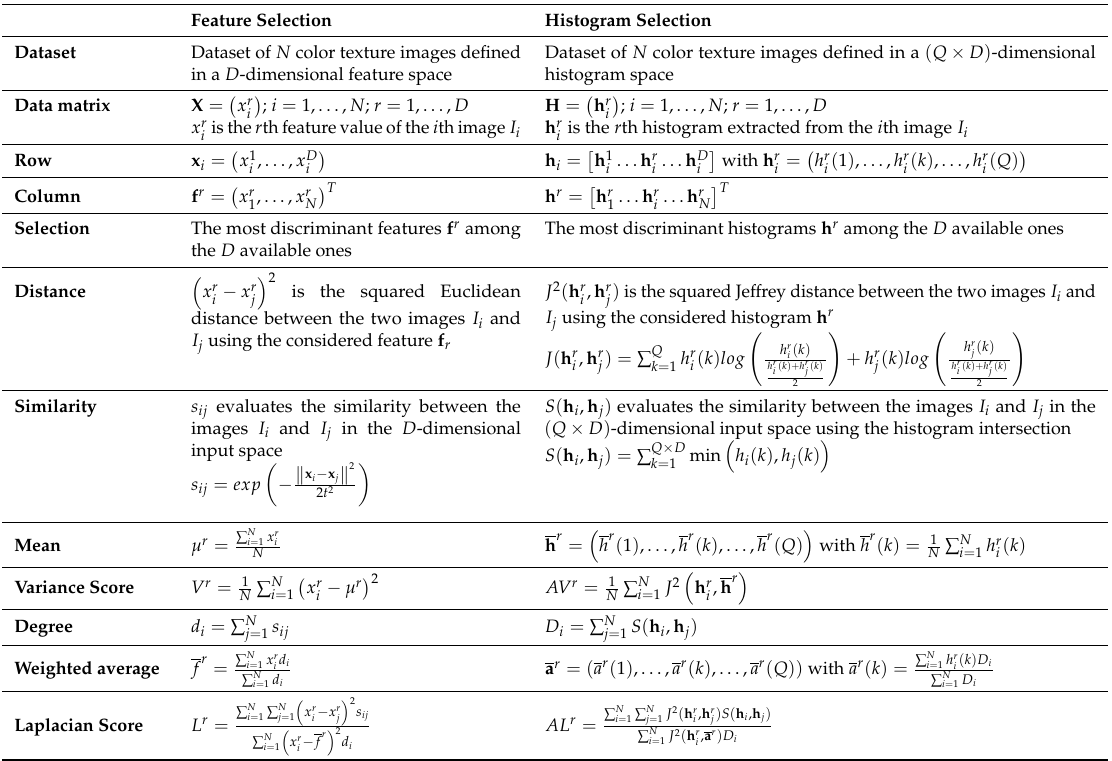
Table 1. Summary of the terms and the scores used in feature selection and their corresponding histogram selection adaptation. Feature Selection Dataset of N color texture images defined Dataset of N color texture images defined in a ( Q × D ) -dimensional in a D -dimensional feature space histogram